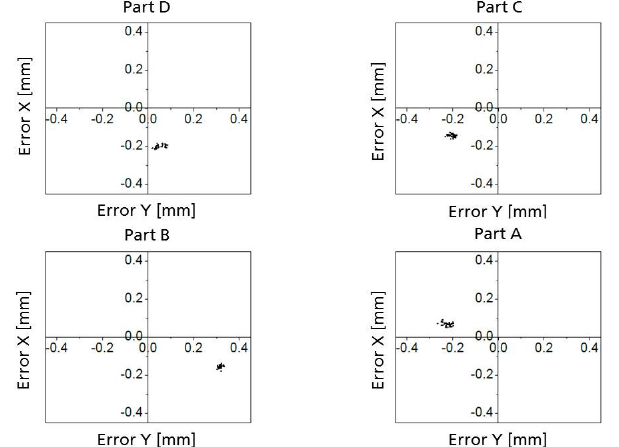
Figure 12. Image data of the stationary camera are shown. Three regions (ROI, red) are used to isolate details of interest. Identified parts (a–d) are grouped and colored by their type (GRIN, HR).